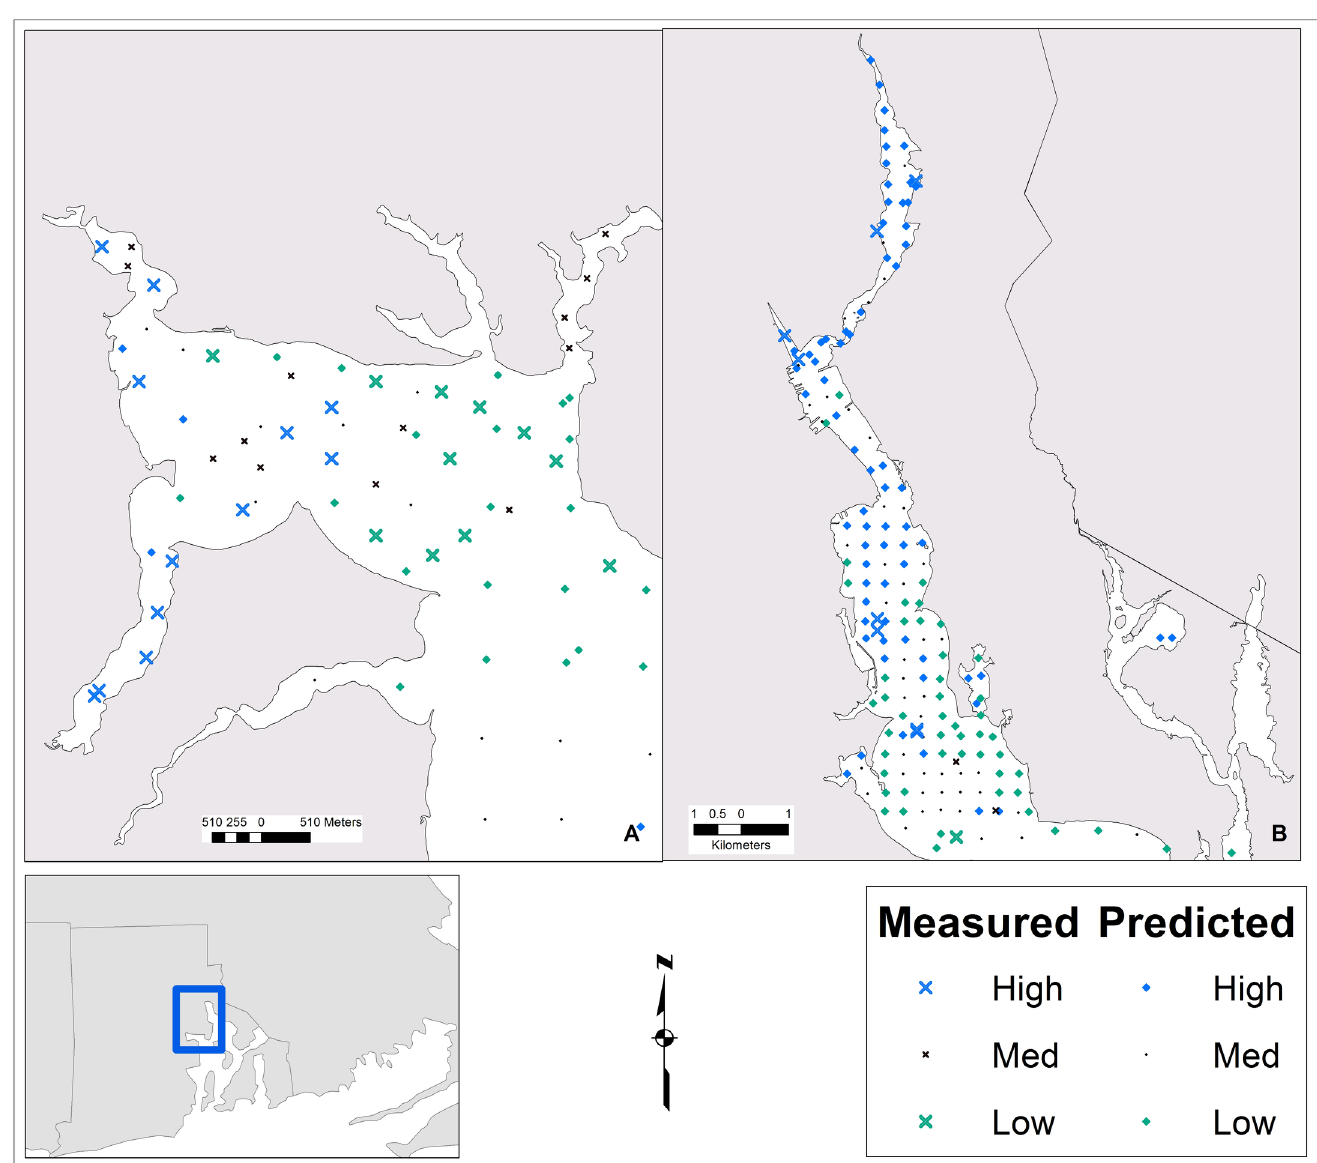
Fig 4. The distribution of model A predicted and measuredtriclosan contamination in the Greenwich Bay (A) and Providence River (B) sub- estuaryof Narragansett Bay, Rhode Island.